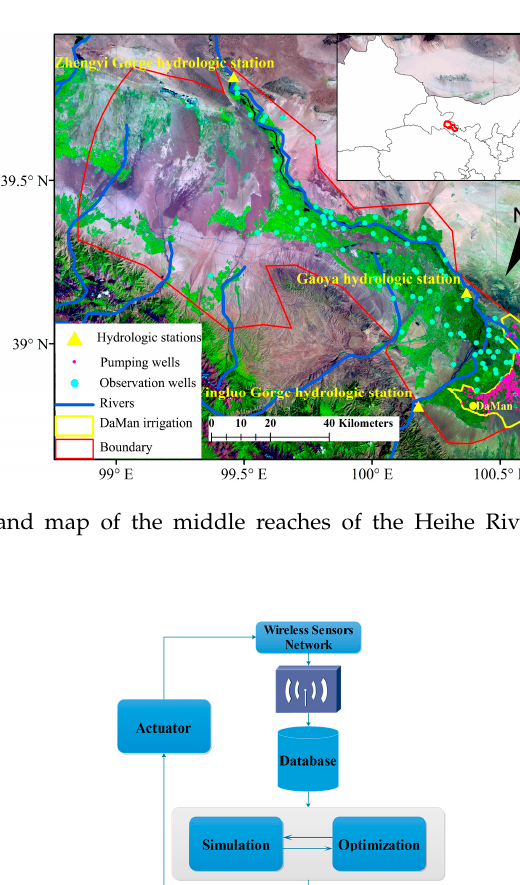
Figure 2. Scheme of the real-time groundwater management system.